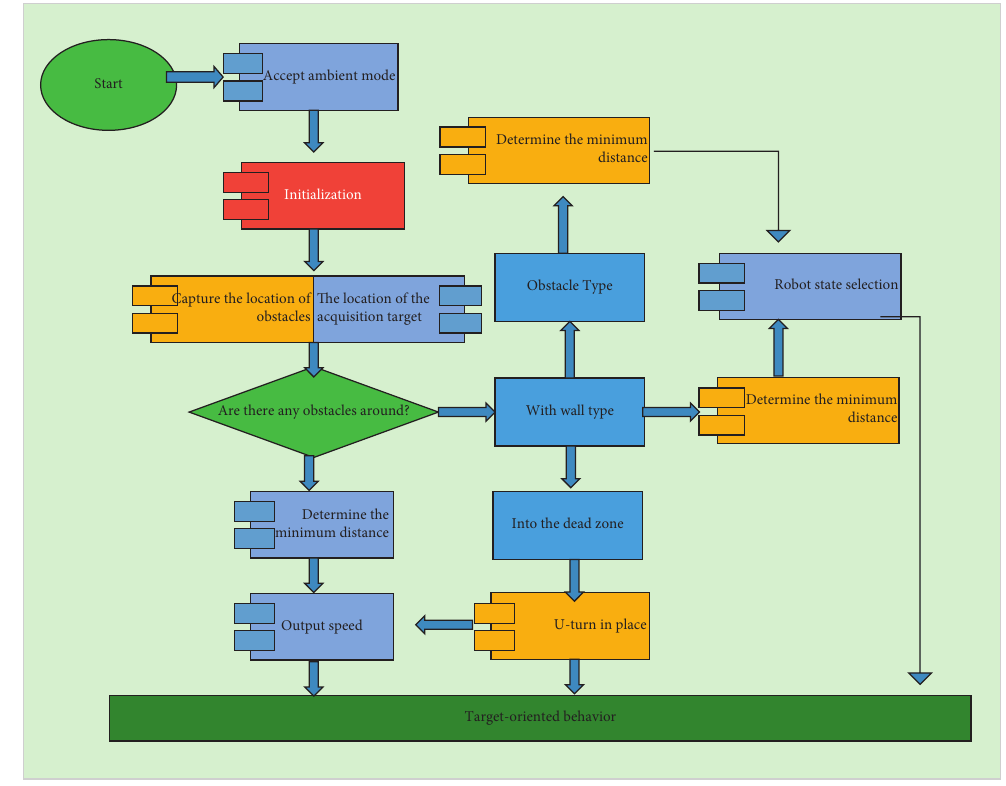
Figure 3: Flowchart of intelligent obstacle avoidance path.